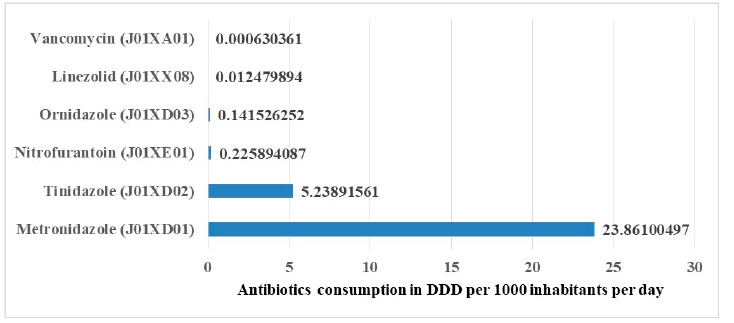
Figure 3. Contribution of each antibiotic in ATC class level J01C ( A ) for amoxycillin per year and ( B ) for the other antibiotics in class J01C utilized over seven years from 2010 to 2016 in Tanzania.